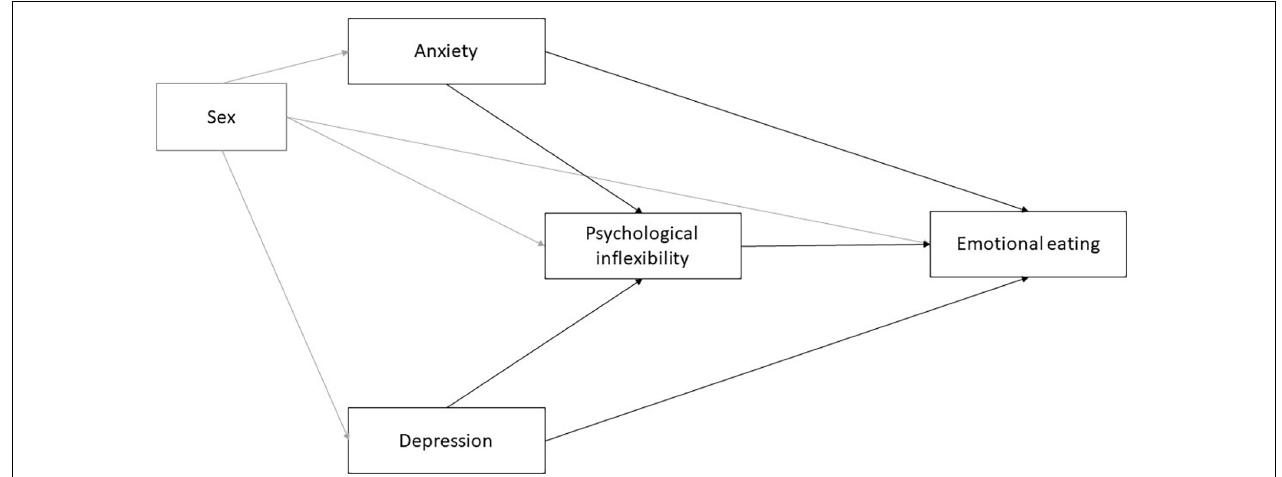
FIGURE 1 | The hypothesized